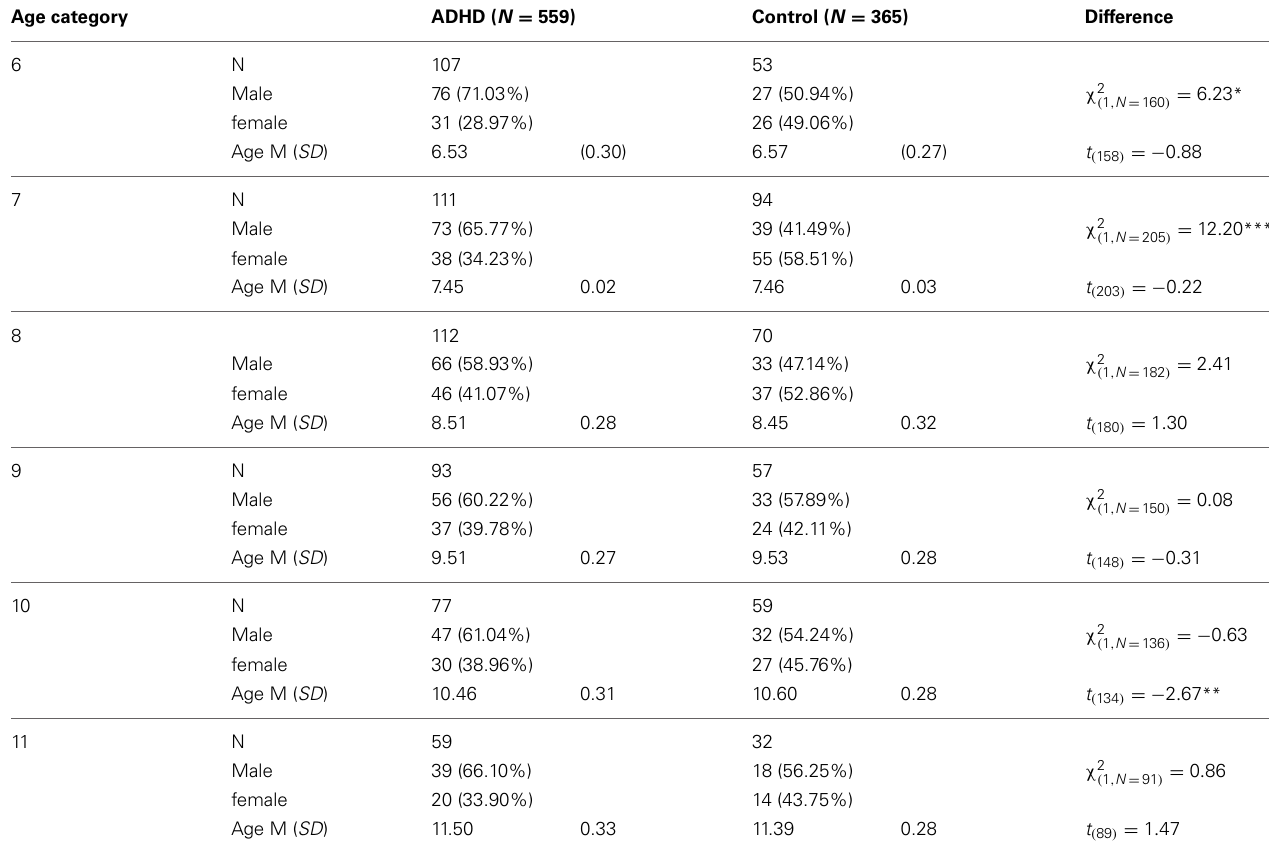
Table 1 | participants’ background